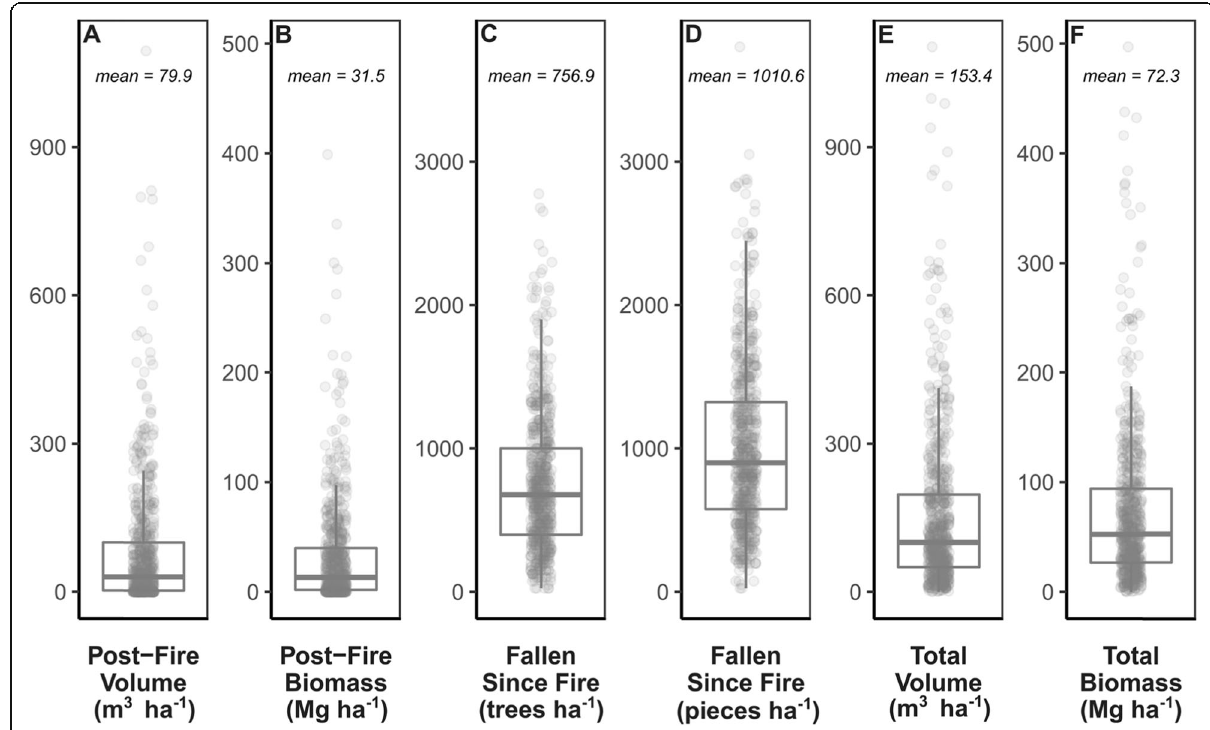
Fig. 3 Spatial heterogeneity in the volume ( a ) and biomass ( b ) of wood that persisted through fire, the number of trees ( c ) and wood pieces ( d ) accumulating post-fire, and the total volume ( e ) and biomass ( f ) of large woody debris on the ground in 2019. Each dot represents one of the 640, 20 m × 20 m quadrats of the Yosemite Forest Dynamics Plot. Heterogeneity is represented by the interquartile range and 95% outer confidence limits represented by the box and whiskers; the median value is the solid line bisecting the box. Mean values reflect the 640 quadrat-